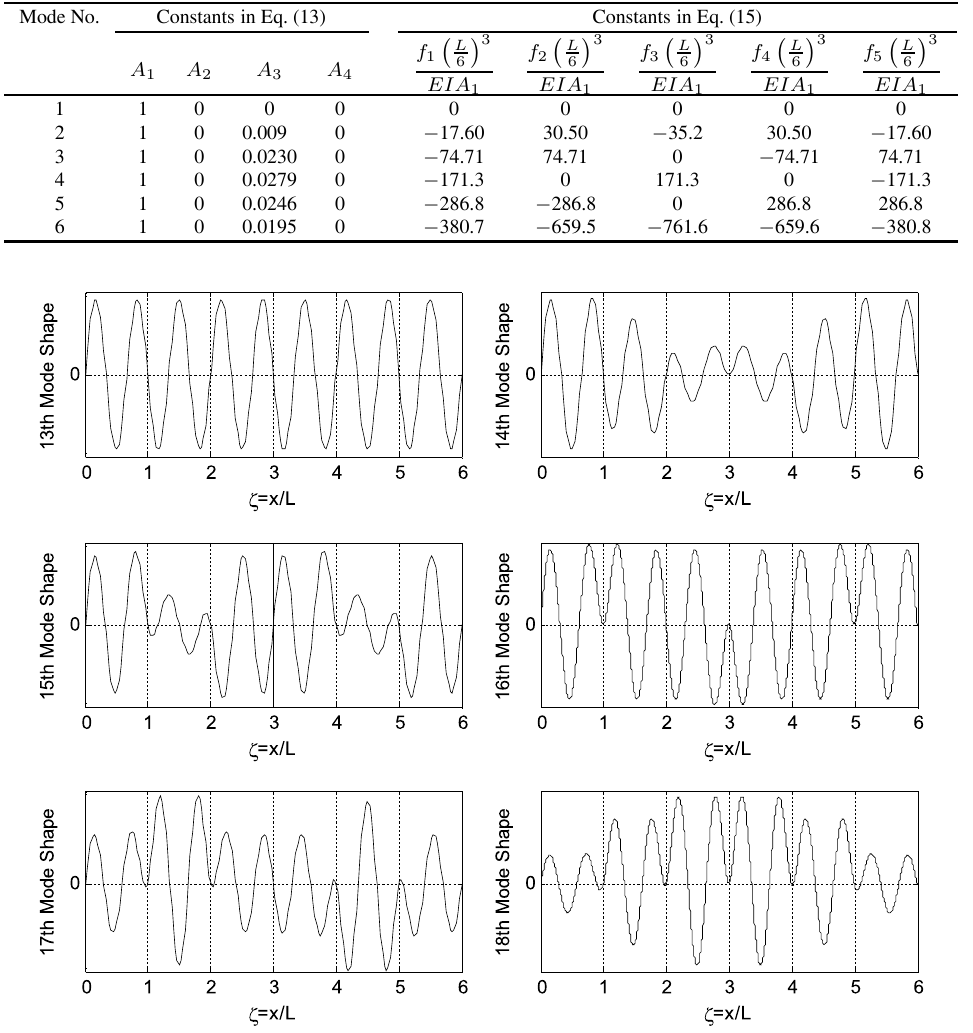
Table 4 Eigen-vectors for fi rst cluster of six-span beam